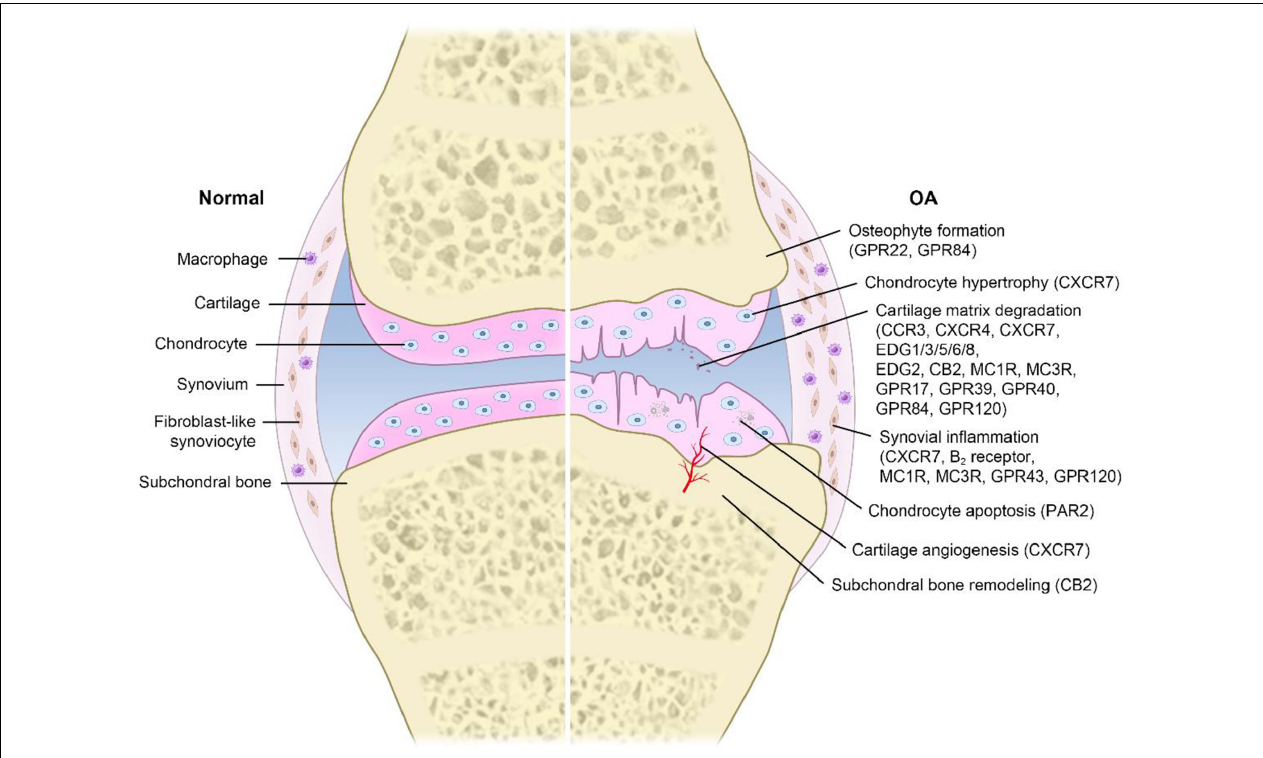
FIGURE 1 | Pathogenesis in OA related to GPCRs. Different GPCRs are widely expressed on various cells and play a key role in transmembrane signal transmission. Extracellular stimuli initiate a series of intracellular signaling pathways by activating GPCRs, leading to a variety of physiological and pathological processes, such as cartilage matrix degradation, synovial inflammation, subchondral bone remodeling, osteophyte formation, chondrocyte hypertrophy, cartilage angiogenesis, and chondrocyte apoptosis. These processes greatly promote the occurrence and progression of